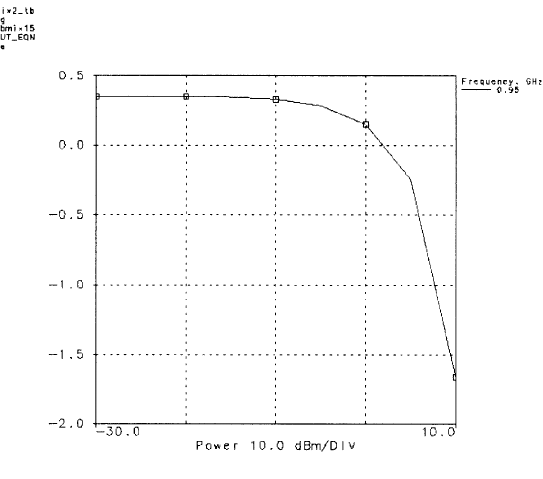
FIGURE 30 Conversion gain vs. the power of the IF signal (considering P LO ¼